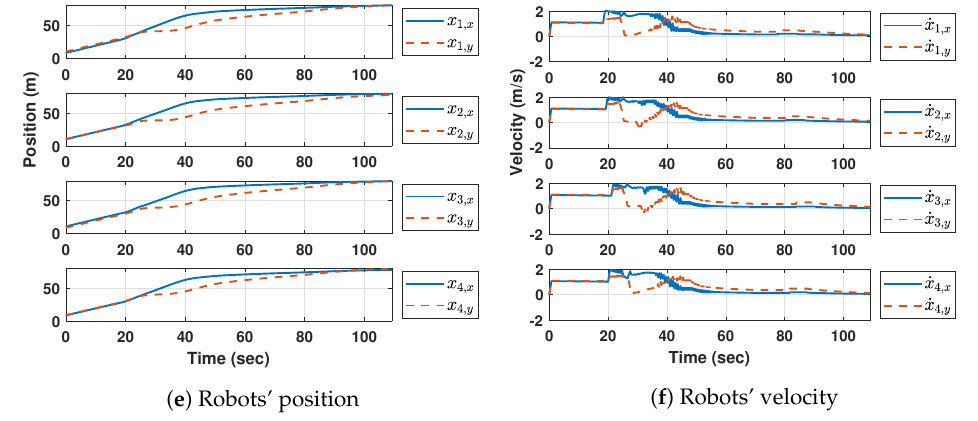
Figure 9. Training results: Scenario 1.